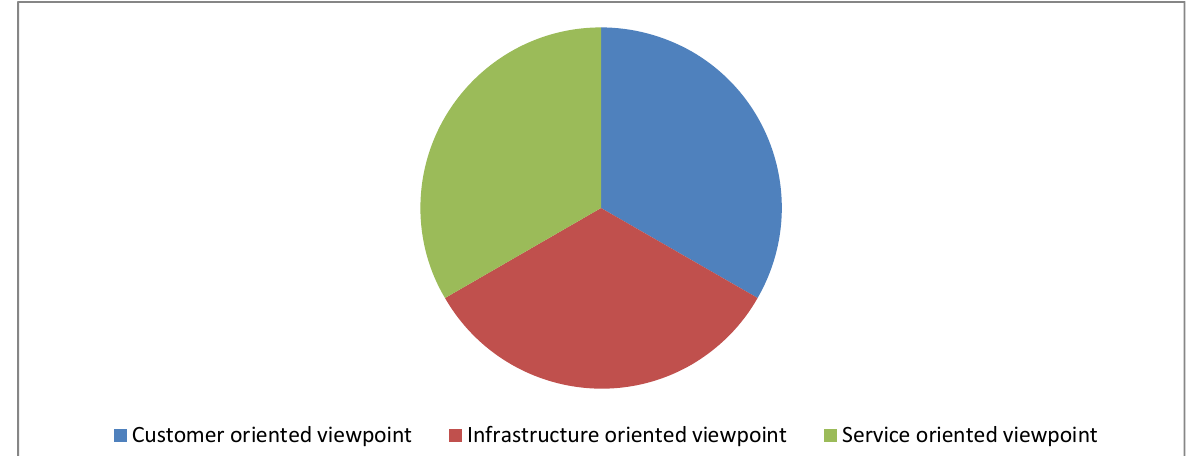
Fig. 4. The represented model to define security requirements of